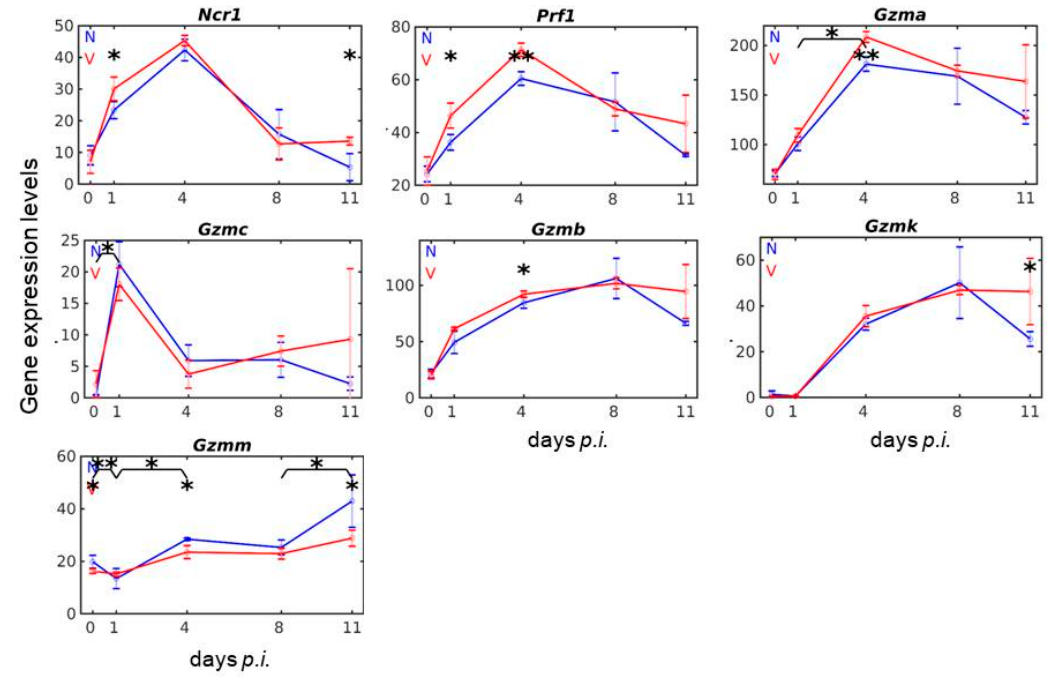
Figure 2. Expression trajectories of genes encoding cytolytic e ff ector molecules in the liver of vaccinated and non-vaccinated mice. RNA was isolated from individual livers prepared from vaccination-protected (V, red) and non-vaccinated (N, blue) mice infected with P. chabaudi blood-stage malaria on days 0, 1, 4, 8, and 11 p.i. Gene expression levels in linear scale are plotted as the means of three microarrays ± SD. The number of “*” marks over interval lines between two sampling points and over the sampling points indicate statistical significance of corresponding intervals and of given sampling points, respectively, between vaccinated and non-vaccinated mice: * p < 0.05; ** p < 0.01.